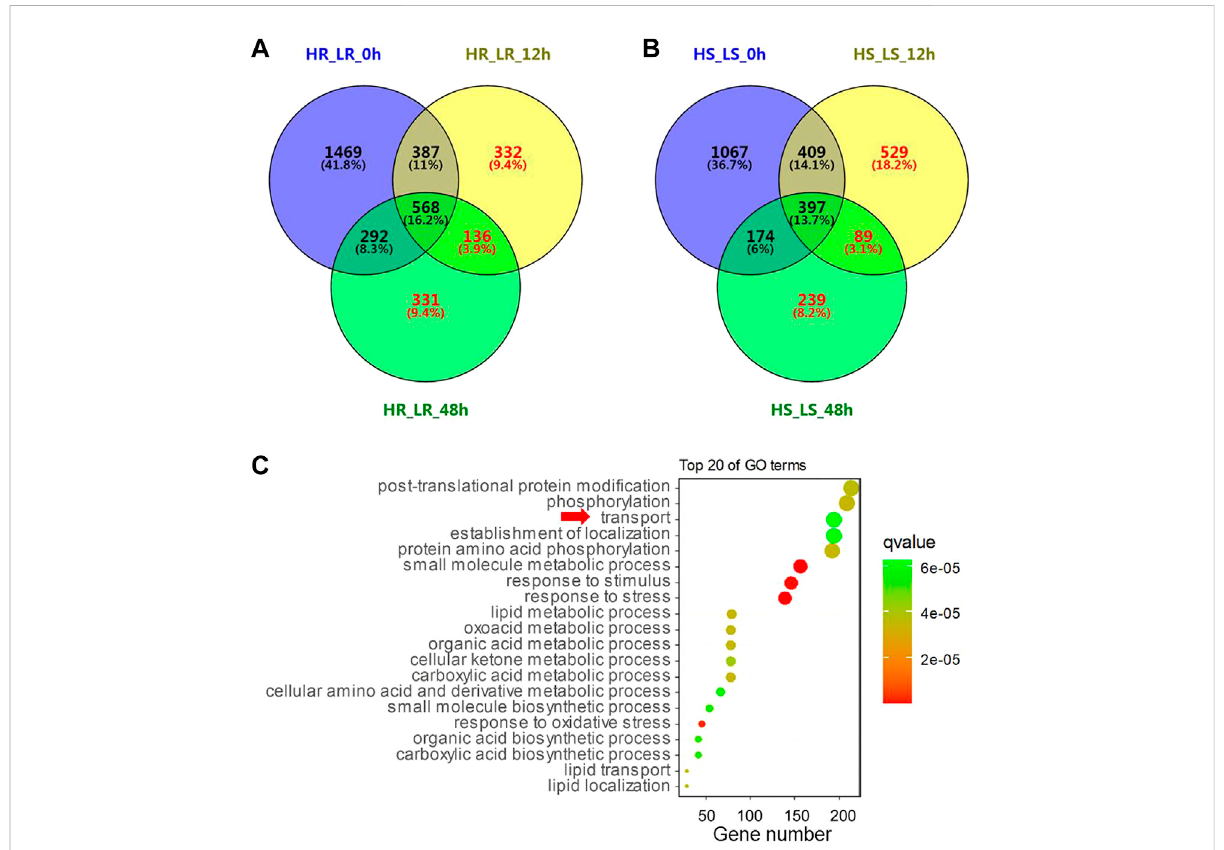
FIGURE 3 Analysis of differentially expressed genes (DEGs). (A) Venn diagram representing the number of DEGs between high and low Cd accumulation varietiesin0 h,12,and48 hafterCdtreatmentintheroot.HandLrepresenttworiceaccessionswithhighCdaccumulationandtworiceaccessions withlowCdaccumulation,respectively. RandSrepresentRNAextracted fromtherootandshoot,respectively. (B) NumberofDEGsintheshoot. (C) GO enrichment of 20 important terms. The size of the circles represents gene numbers enriched in the GO